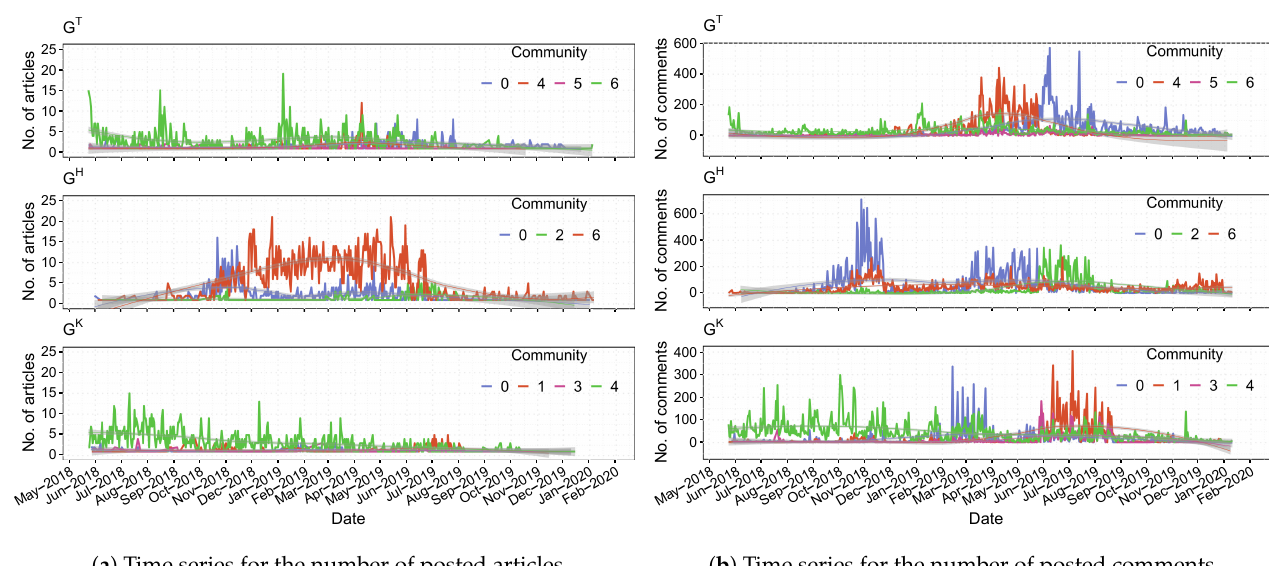
( a ) Time series for the number of posted articles ( b ) Time series for the number of posted comments Figure 8. Time series for the number of articles and the number of comments posted by malicious users in each community of the ACMN from 24 May 2018 to 11 January 2020 (the election